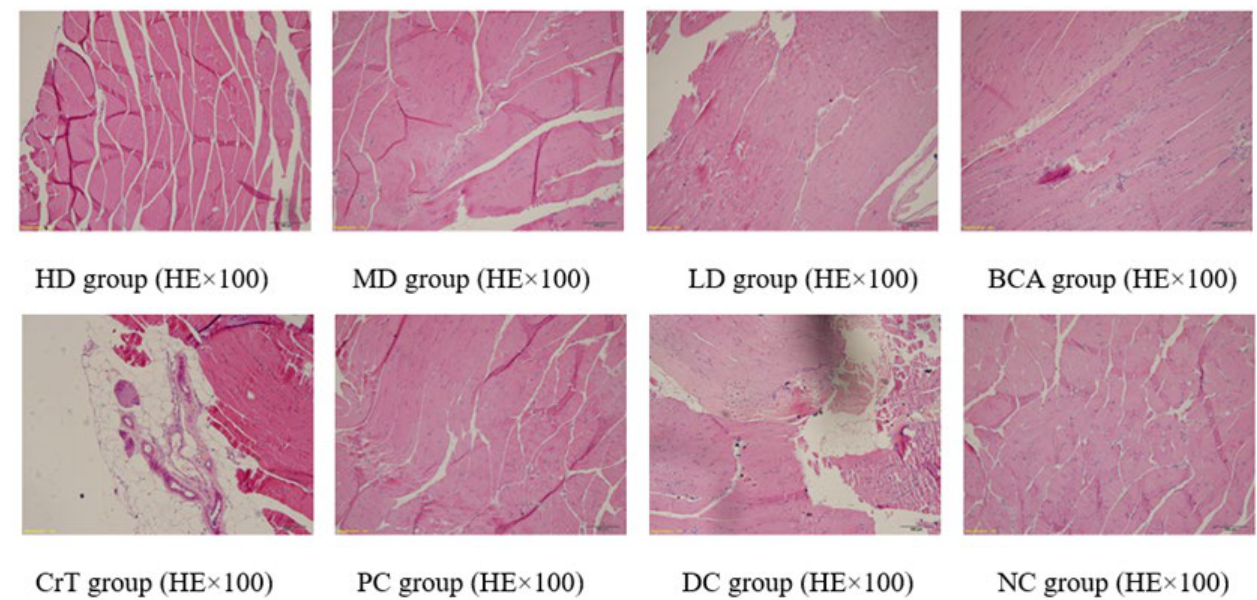
Figure 14. Morphological changes in skeletal muscle